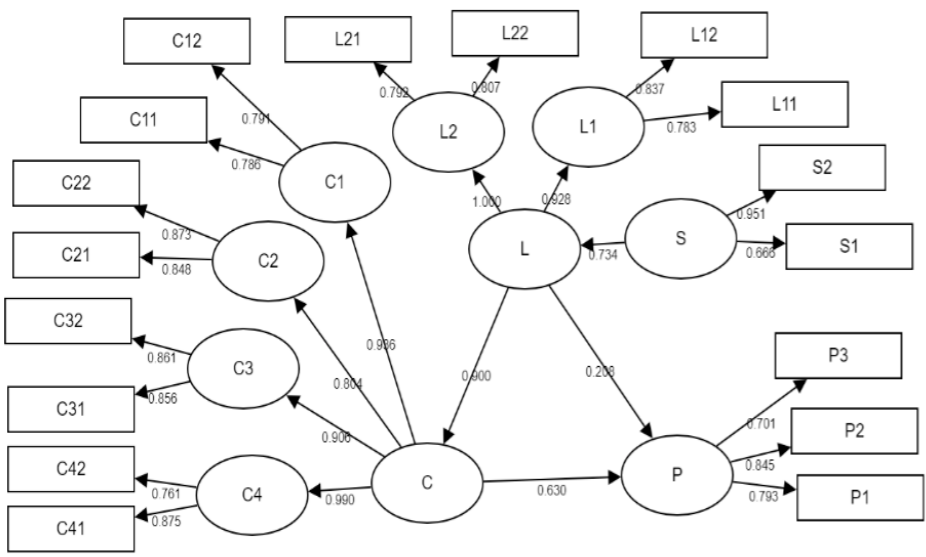
Figure 2. Structural Equation Model.